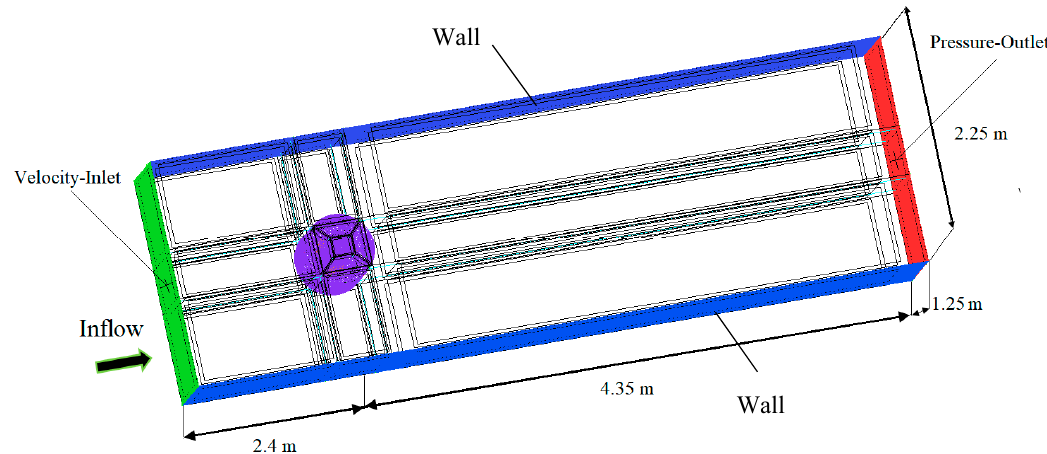
Figure 2. Computational domain and mesh blocks.